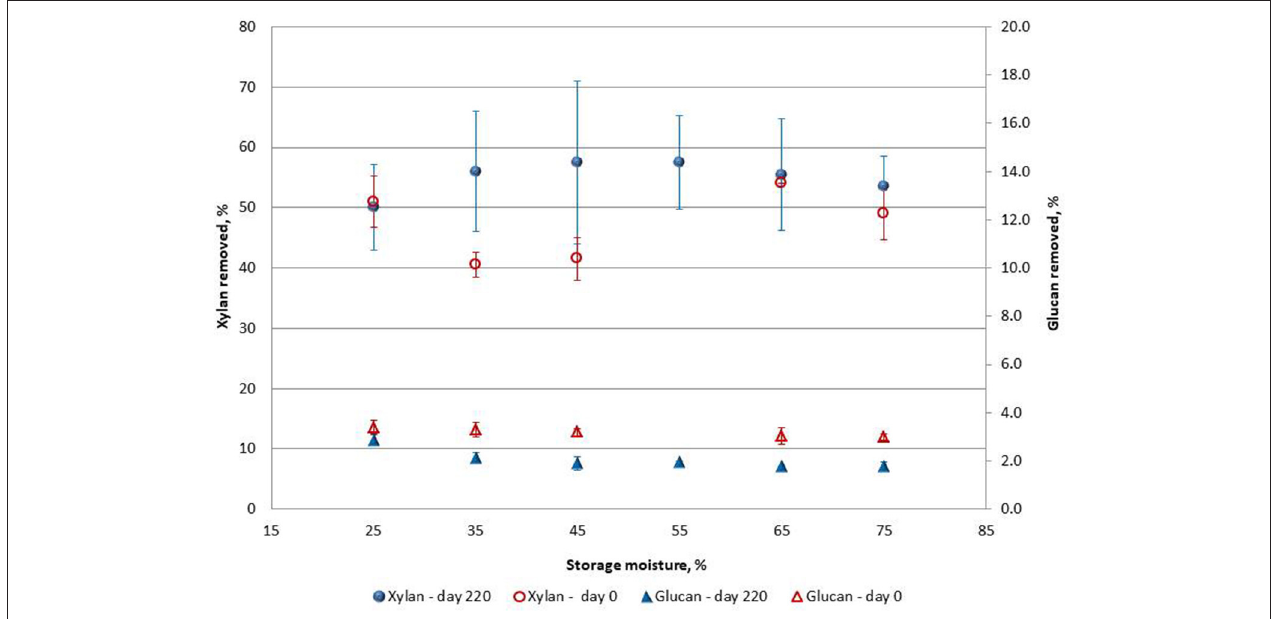
FIGURE 3 | Xylan and glucan removal during LHW pretreatment of ensiled (day 220) and unensiled (day 0) PA stover. Error bars are standard deviations of mean (Data for 55% moisture, Day 0 missing).